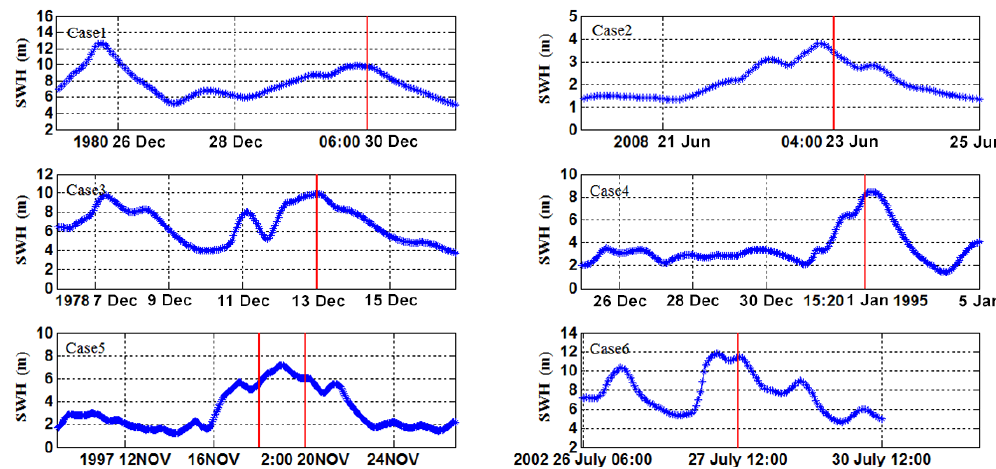
Figure 1. Time series of simulated significant wave height (cases 1–6), red lines refer to the freak waves occurrence